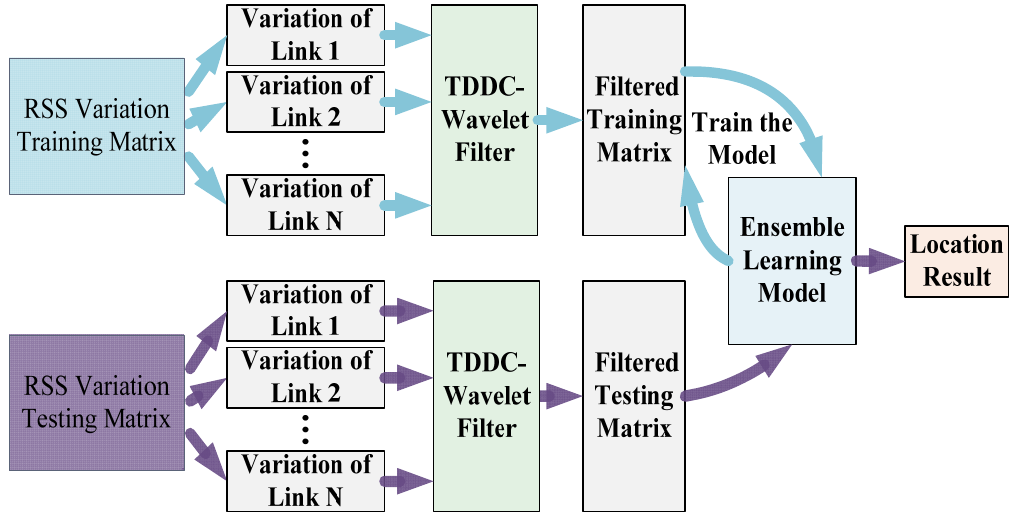
Figure 2. The overall architecture of the DFL algorithm proposed in this paper.